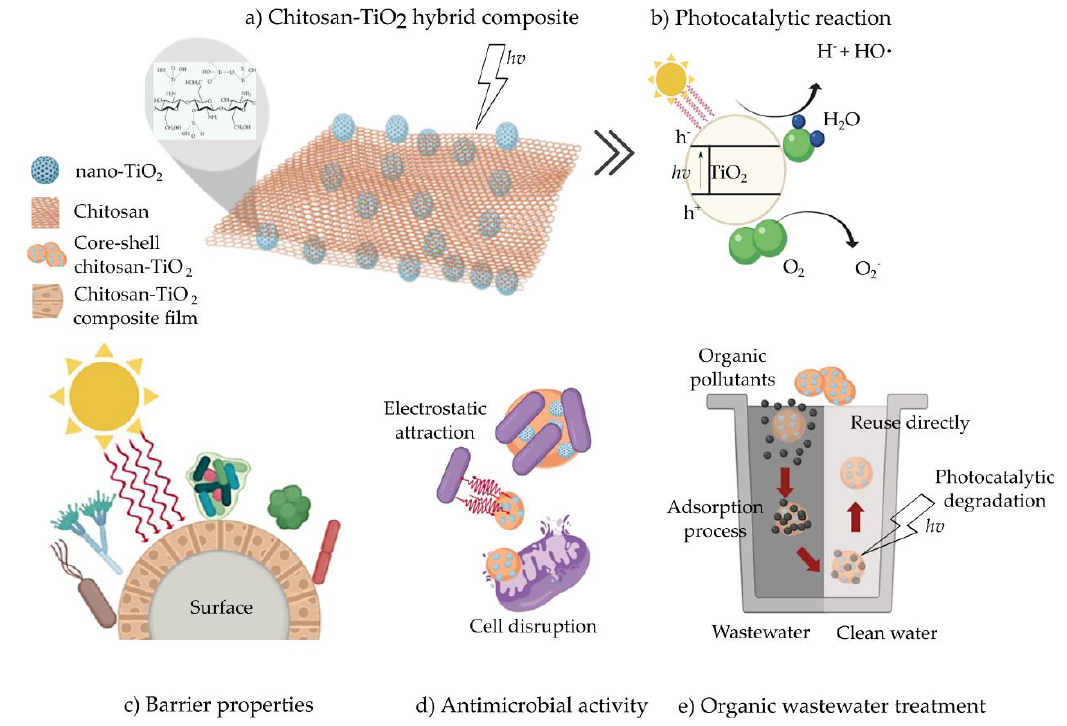
Figure 3. Chitosan – TiO 2 hybrid composites and their applications ( a ) photocatalytic property, ( b ) potential barrier ( c ), antimicrobial ( d ), and wastewater ( e ) applications (figure created in Biorender.com).